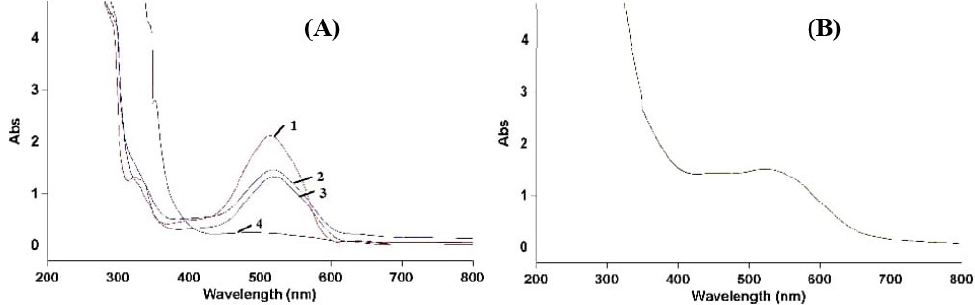
Figure 14. UV–vis absorption spectra ( A ) of the drink before extraction ( 1 ) and 30 ( 2 ), 45 ( 3 ), and 120 min ( 4 ) after the start of extraction. ( B )—UV–vis absorption spectrum of anthocyanin. The characteristic absorption band (Figure 14B) corresponding to the natural antho- cyanin of the cherry, represented by the two compounds cyanidin-3-glucosylrutinsoid (Cy-3-GR) and cyanidin-3-rutinoside (Cy-3-R) (Figure 15), was not detected. Figure 16 shows the dynamics of SPE of MB with an absorption maximum at 664 nm.